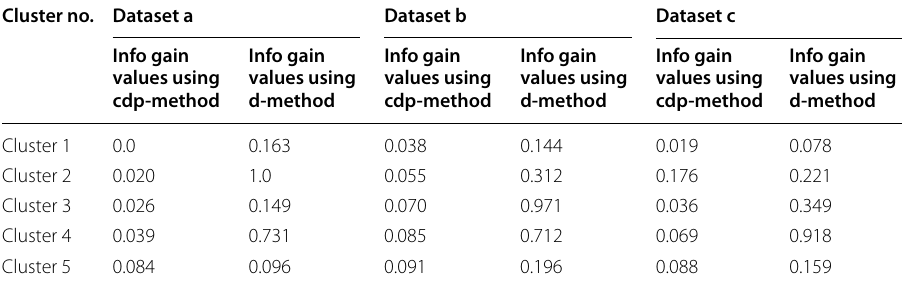
Table 7 Information gain values for different clusters using cdp-method [5] and the proposed